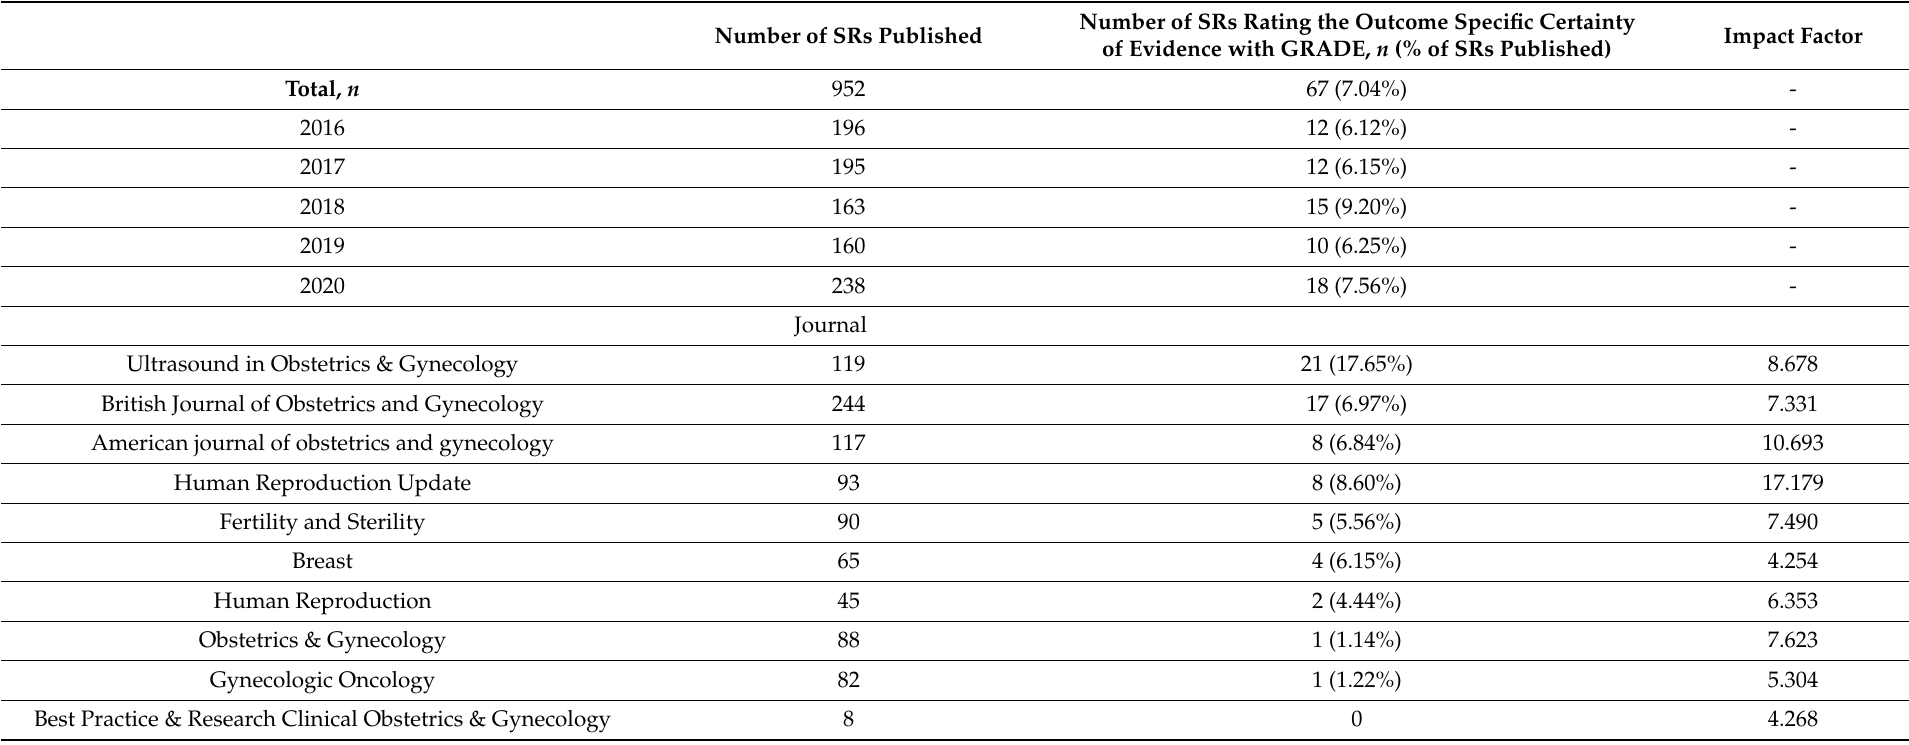
Table 1. The distribution of systematic reviews ( n = 67) that rated the outcome-specific certainty of evidence with GRADE by year and